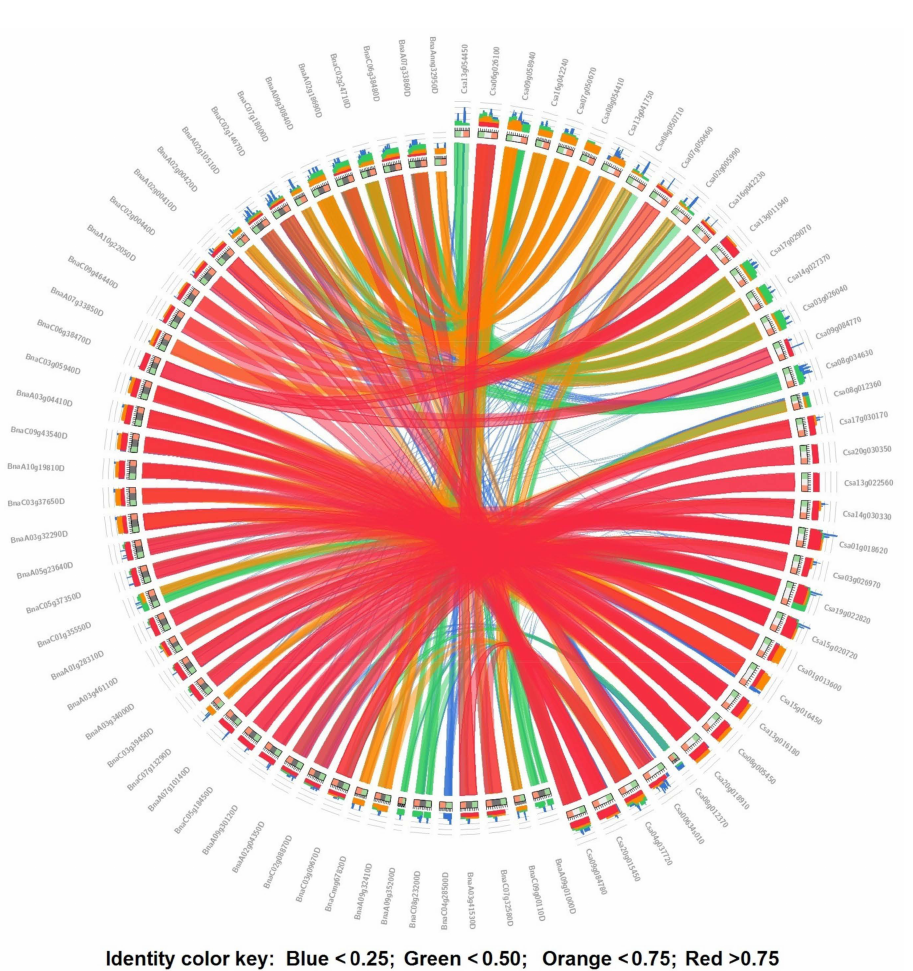
Figure 4. The synteny relationships between the SULTRs from Camelina sativa and Brassica napus